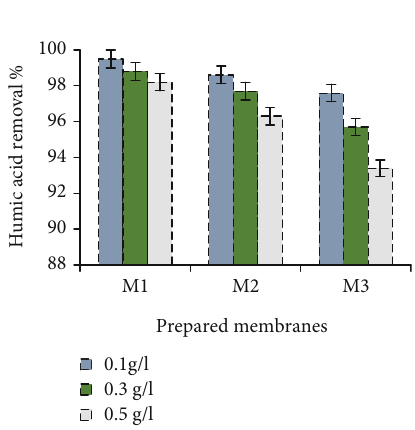
Figure 6: Removal percentage of humic acid using prepared membranes.